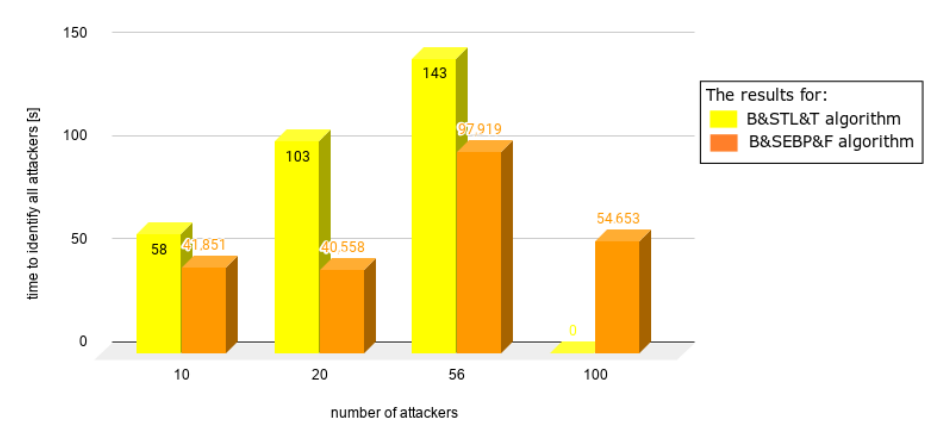
Figure 13. Results from experiments no. 12, 13, 14, and 15 (experiments can be found in Tables 3–7); the graph presents a different scenario in which there are no regular users on the road.